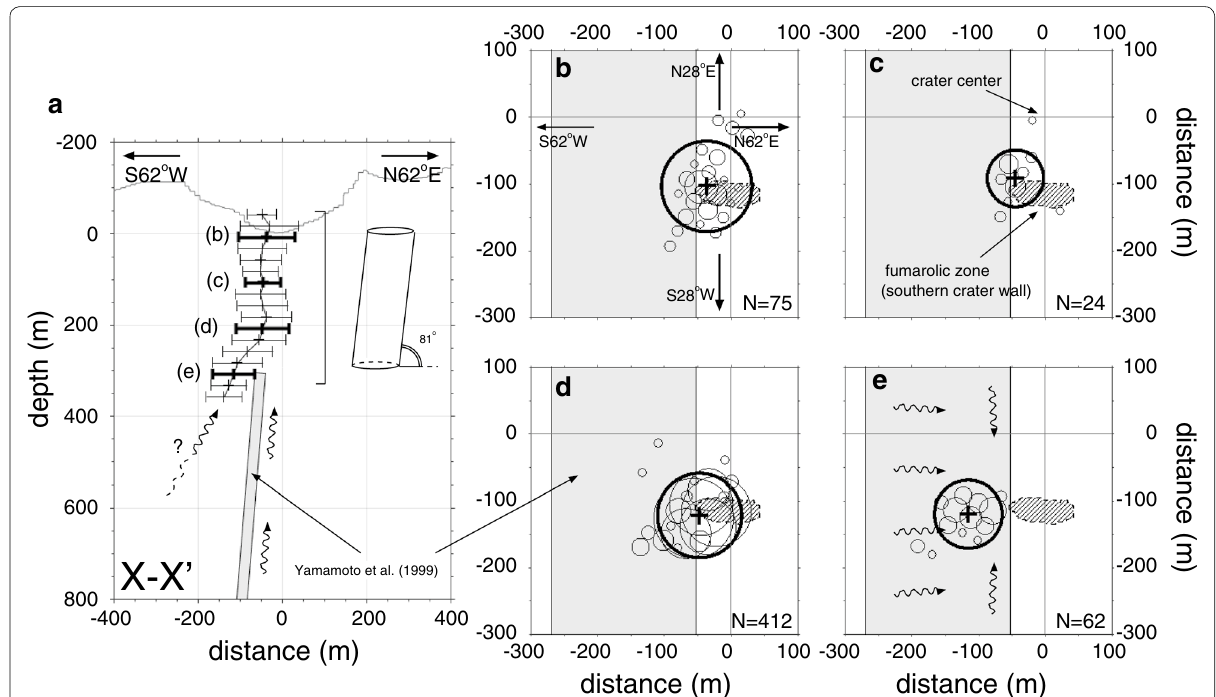
Fig. 10 The region containing the sources of the continuous tremors is an inclined cylinder. a Weighted centroid of estimated CT source locations ( N p = 10 ; black circles in Fig. 9) at each depth with a disk size (horizontal bar). The results are projected on a vertical plane perpendicular to the strike direction of the crack (gray area; Yamamoto et al. 1999). The distribution of these disks consists of an inclined cylindrical region (dip is 80.7 ◦ ; inserted sketch). Wiggly lines indicate the flow direction of the volcanic fluid. b – e Horizontal distribution of both the apparent disk area of the cylindrical region (thick circle) and all estimated source locations (thin circles) at depths of 0, 100, 200, and 300 m, respectively. The size of each thin circle indicates the number of crossovers. The total number of source estimations (30-min windows) is shown in the lower right. The hatched area corresponds to a fumarolic zone at the southern crater wall (Fig. 2). The wiggly lines in e show the flow directions not only at a depth of 300 m, but also in the entire region of the